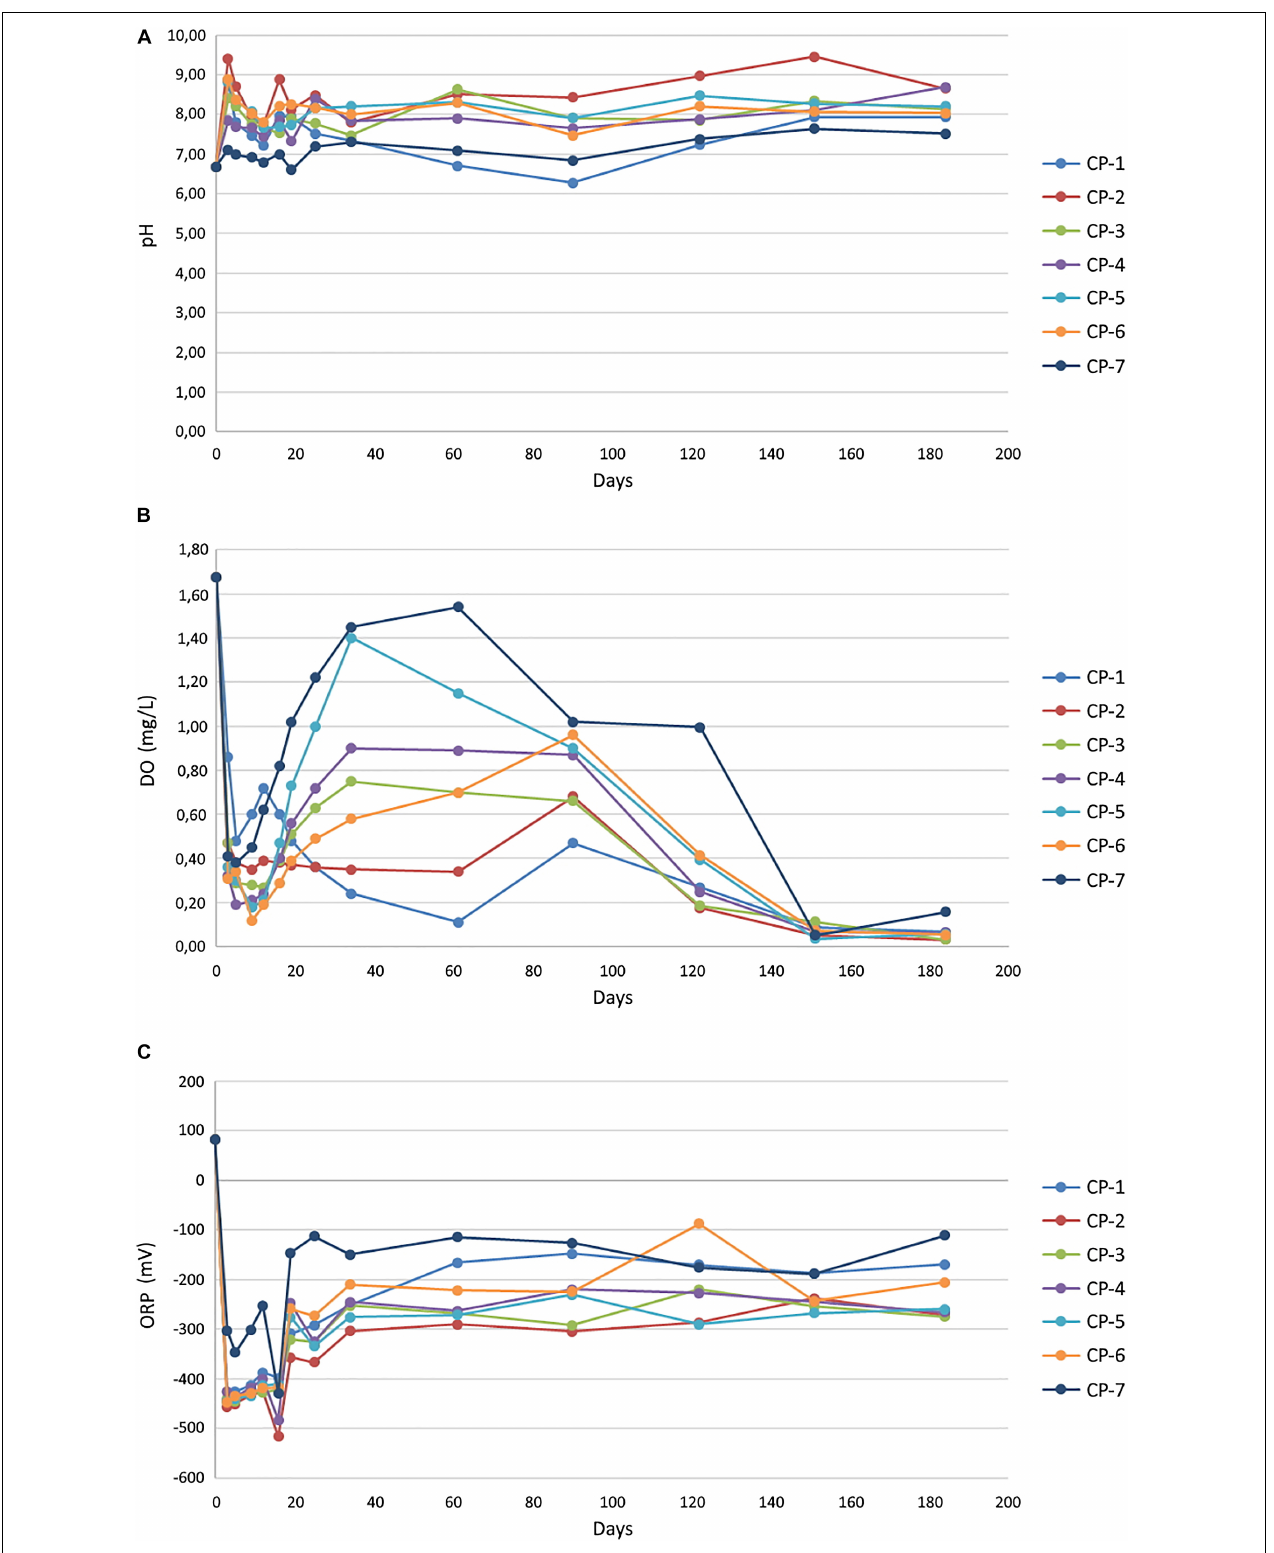
FIGURE 3 | Groundwater pH (A) , oxygen concentration (B) and oxidation-reduction potential (ORP) (C) , in the different wells of the soil, before (0) and after the injection of nZVI nanoparticles. The values obtained for individual wells correspond to the average of three measurements with a standard error < 5%.